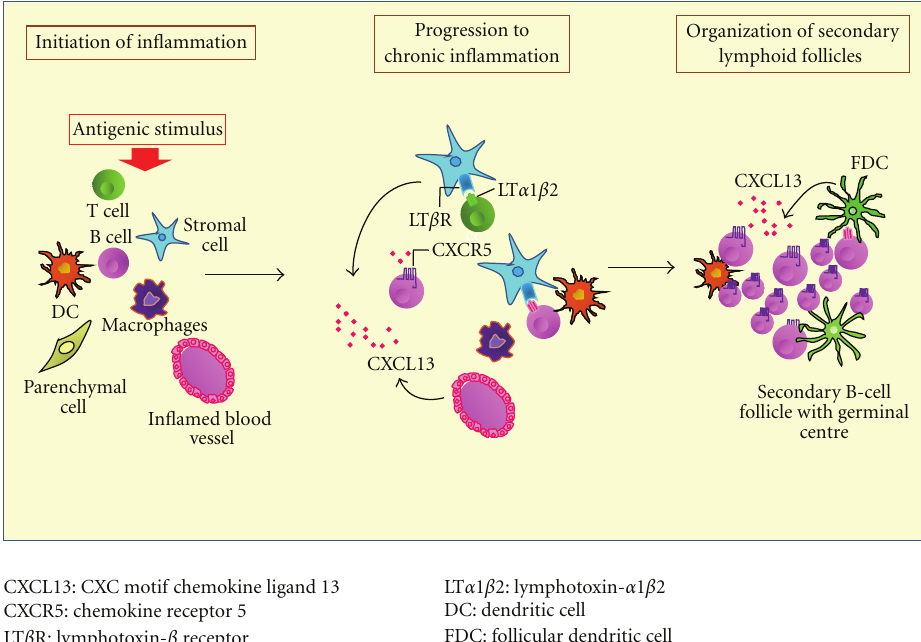
Figure 4: Schematic representation of chronic inflammation and organization of secondary lymphoid follicles in HCV chronic infection. The ability of HCV to chronically persist in the host may represent a continuous stimulus for the immune system resulting in B-cell oligo/monoclonal expansions with selective advantage to clones depending on antigen stimulation. Some chemokines may play a crucial role in the establishment of an adequate microenvironment for activation and expansion of B-lymphocytes in response to signals provided by antigen-presenting cells. Among them, CXC motif chemokine ligand 13 (CXCL13) and its chemokine receptor 5 (CXCR5) are important for secondary lymphoid tissue development and distribution of lymphocytes within microenvironments. CXCL13 is released by endothelial and stromal cells mediated by lymphotoxin- β receptor (LT β R) signaling and contributes to lymphoid homing in the liver by the creation of a favourable microenvironment sustaining focal B-cell aggregation similar to lymphoid